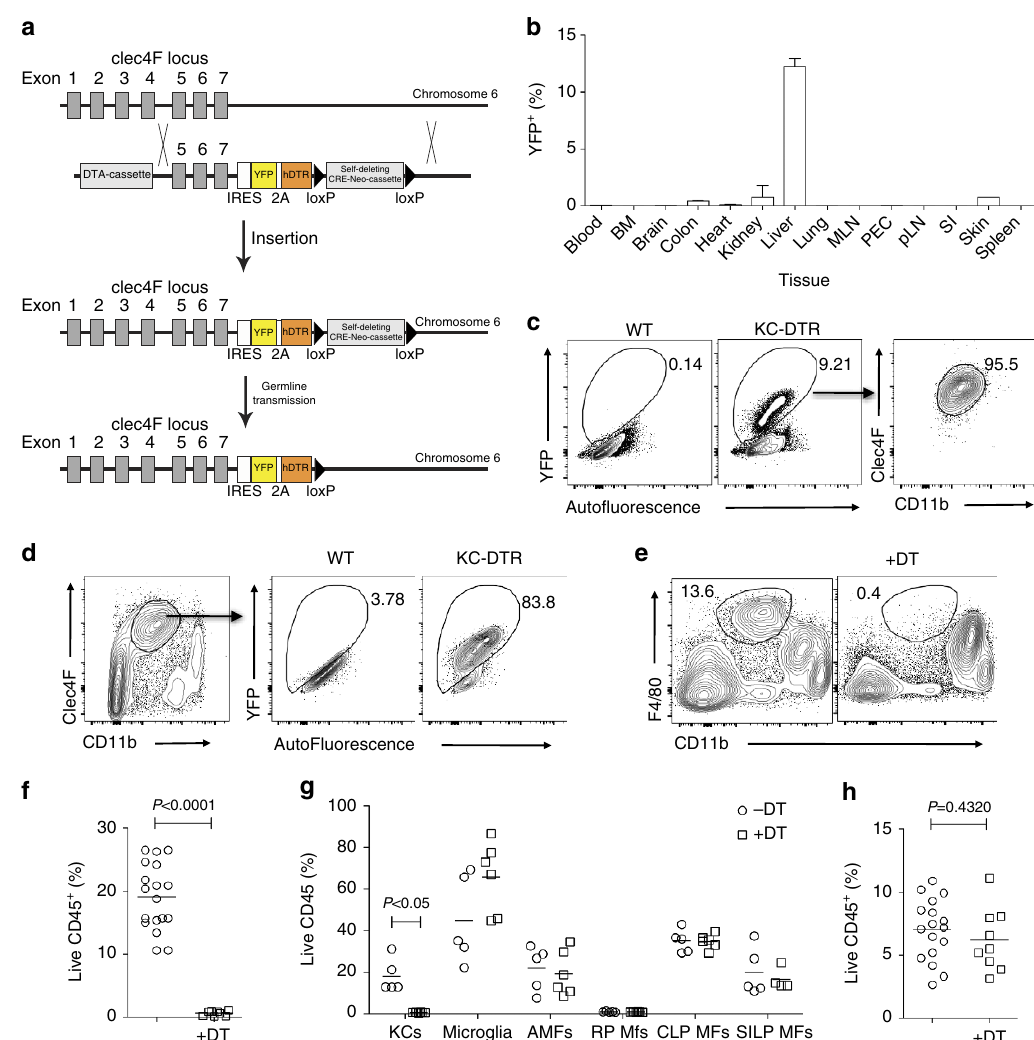
Figure 2 | Generation and validation of KC-specific KC-DTR mice. ( a ) Schematic showing generation of KC-DTR mice. ( b ) Percentage of YFP-expressing cells amongst live cells in different tissues of KC-DTR mice. One experiment. n ¼ 3 per group. Error bars represent s.e.m. ( c ) Liver homogenates from KC-DTR mice or WT littermate controls were examined for YFP expression and YFP þ cells were examined for Clec4F and CD11b expression. Representative of three experiments. ( d ) YFP expression by Clec4F þ CD11b int KCs from KC-DTR mice or WT littermate controls. Representative of three experiments. ( e ) F4/80 and CD11b expression amongst live CD45 þ cells 24h post administration of DT to KC-DTR mice or WT littermate controls. Representative of five experiments. ( f ) Proportion of KCs amongst live CD45 þ cells 24h post administration of DT. Data are pooled from three experiments. n ¼ 18 (controls) or 8 ( þ DT). P o 0.0001 two-way Student’s t -test. ( g ) Tissue-resident m f s (AMFs, Alveolar m f s; CLP MFs, Colonic